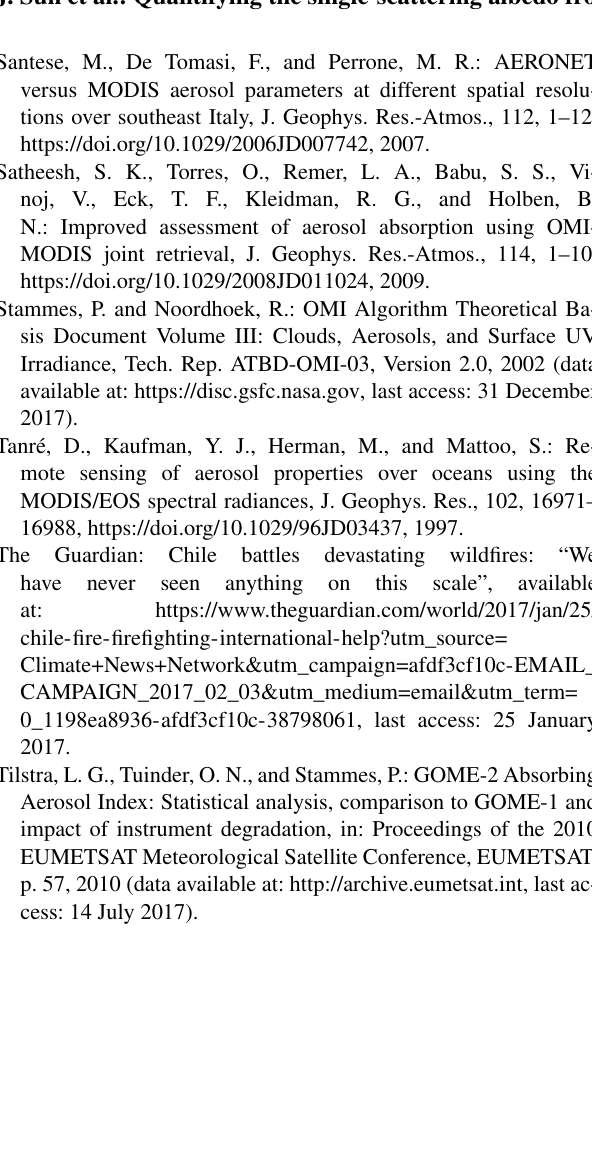
table, last access: 17 July